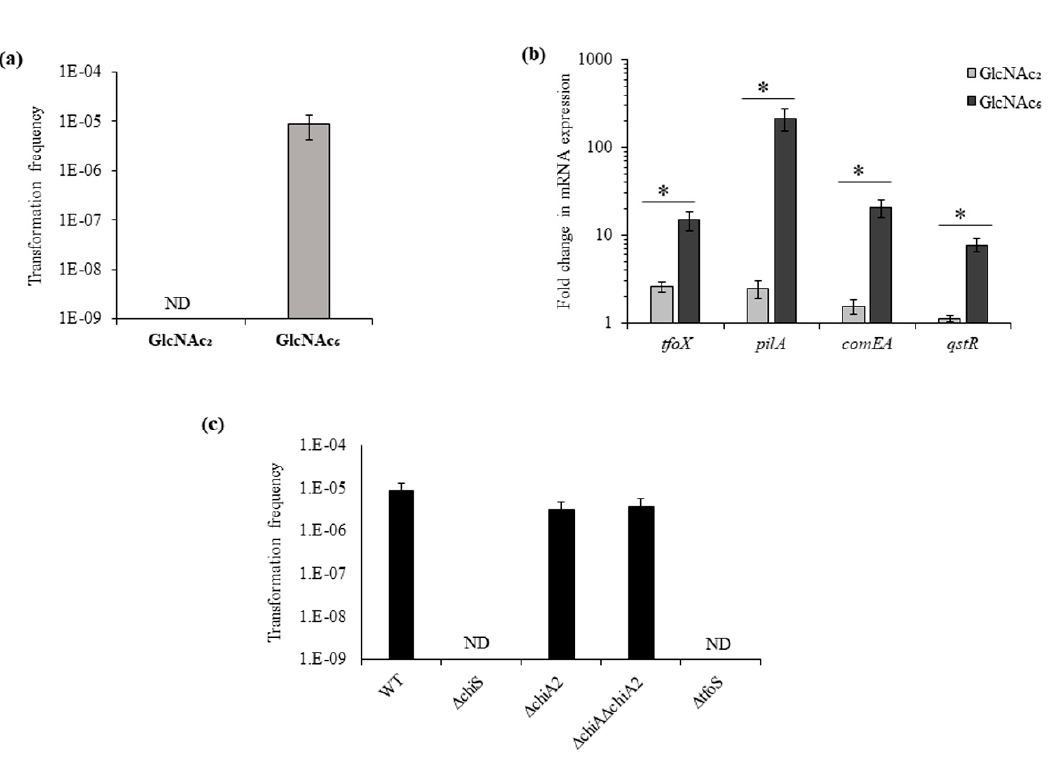
Figure 5. GlcNAc 6 induced competence state in V. parahaemolyticus require ChiS as well as TfoS. ( a ) Induction of natural competence in WT in the presence of chitin oligosaccharides: 5 mM GlcNAc 2 and 1.25 mM GlcNAc 6 supplemented DASW. ( b ) The relative mRNA expression of competence genes tfoX , pilA , comEA and qstR was compared in the presence of GlcNAc 2 and GlcNAc 6 in the wild type strain. Each bar indicates the mean ± SE of three independent experiments. * represents a p -value < 0.05 ( c ) GlcNAc 6 used for natural transformation in WT and indicated mutants. Each bar represents the mean ± SE of three independent